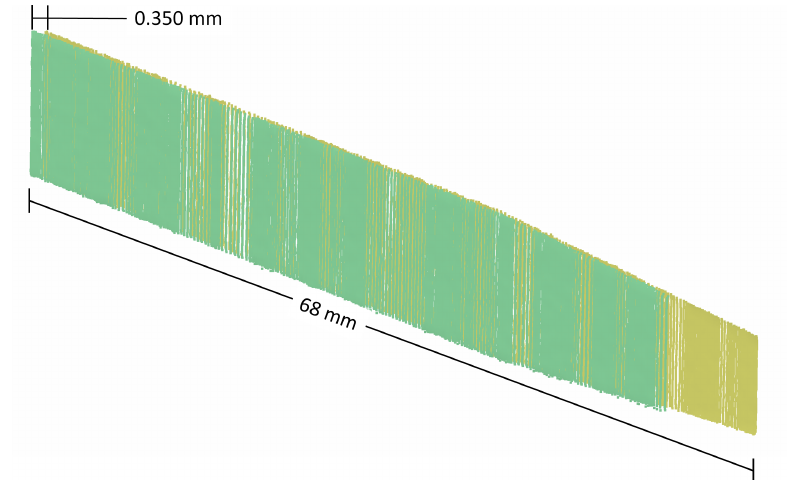
Figure 4. Representative point clouds of a thickness gauge measurement. Green points belong to the front side and yellow points to the black side of the gauge. Table 2. Target-performance comparison of three independent measuring series. Units: (mm).